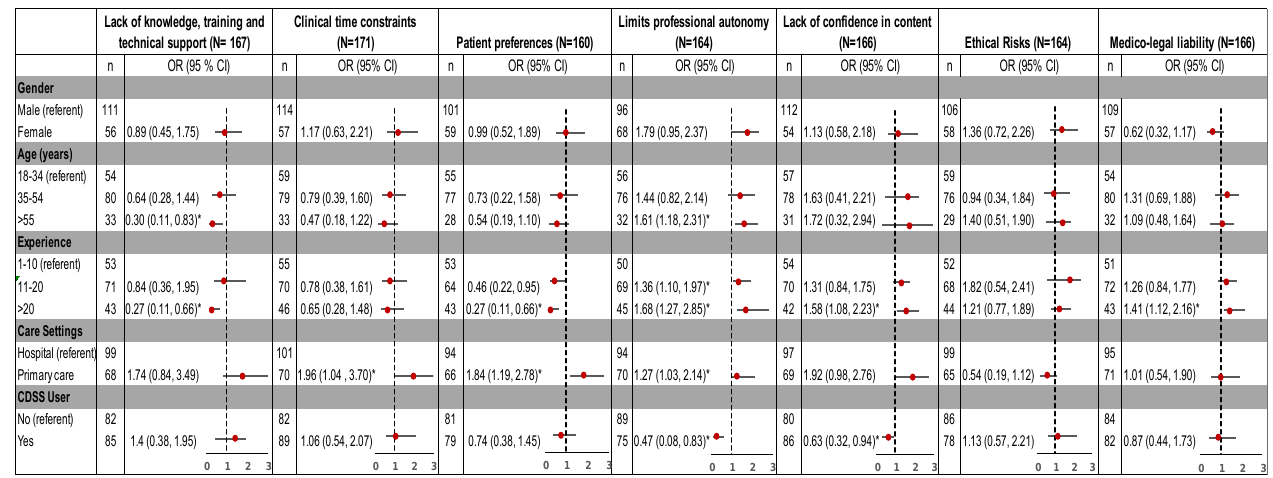
Figure 5. Association of perceived barriers to implementation of CDSS, by demographic characteristics. OR: odds ratio; CI: confidence interval. * Significant predictors as confidence interval does not include 1.0.